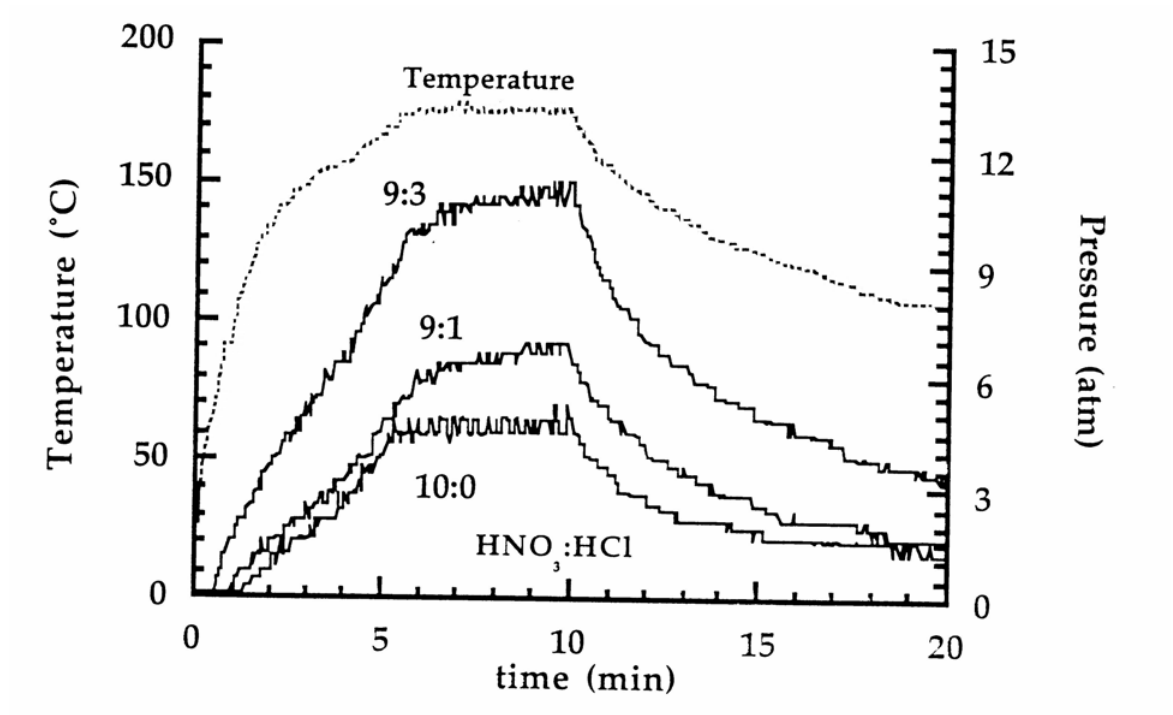
PRESSURE PROFILES FOR THE HEATING OF DIFFERENT RATIOS OF NITRIC ACID TO HYDROCHLORIC ACID